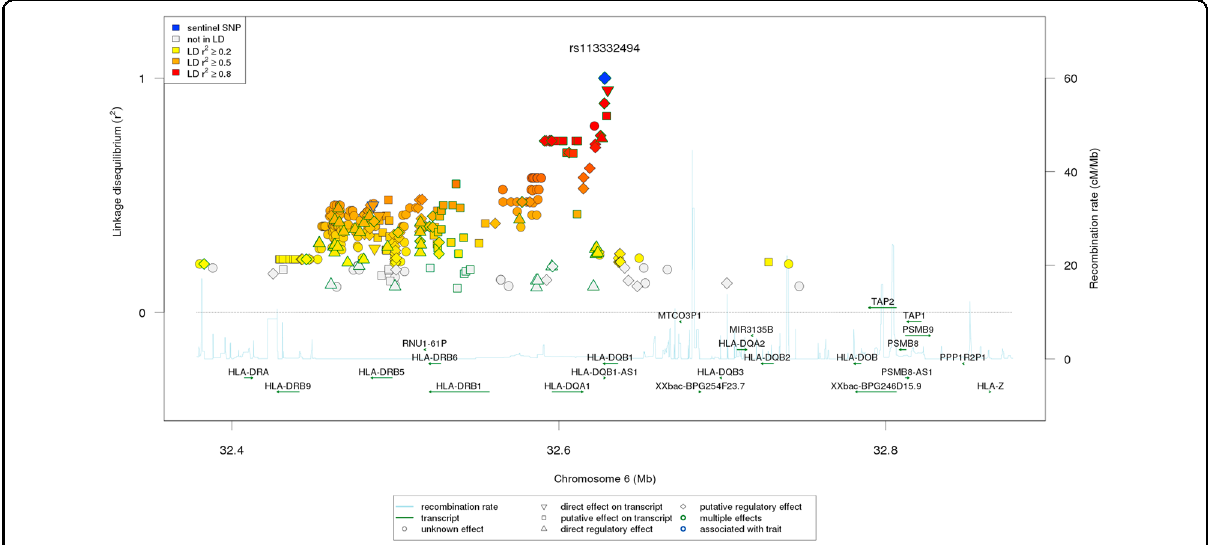
Fig. 3 Linkage disequilibrium plot. Linkage disequilibrium of rs113332494 with surrounding markers coloured by strength of LD in 1 KG European super